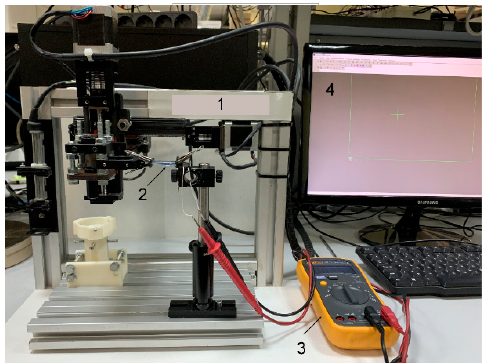
Figure 3. Installation for determining the sensitivity: 1—movement module with moving head in coordinates (x;y;z), 2—strain sensor, 3—digital multimeter connected to strain sensor, 4—personal computer for controlling the movement module.